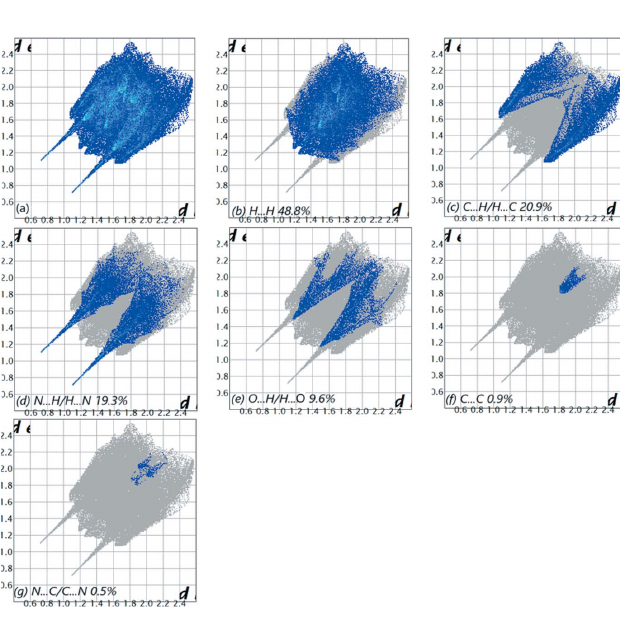
Figure 5 The full two-dimensional fingerprint plots for the title compound, showing ( a ) all interactions, and delineated into ( b ) H (cid:3)(cid:3)(cid:3) H, ( c ) H (cid:3)(cid:3)(cid:3) C/ C (cid:3)(cid:3)(cid:3) H, ( d ) H (cid:3)(cid:3)(cid:3) N/N (cid:3)(cid:3)(cid:3) H, ( e ) H (cid:3)(cid:3)(cid:3) O/O (cid:3)(cid:3)(cid:3) H, ( f ) C (cid:3)(cid:3)(cid:3) C and ( g ) C (cid:3)(cid:3)(cid:3) N/ N (cid:3)(cid:3)(cid:3) C interactions. The d i and d e values are the closest internal and external distances (in A˚ ) from given points on the Hirshfeld surface.